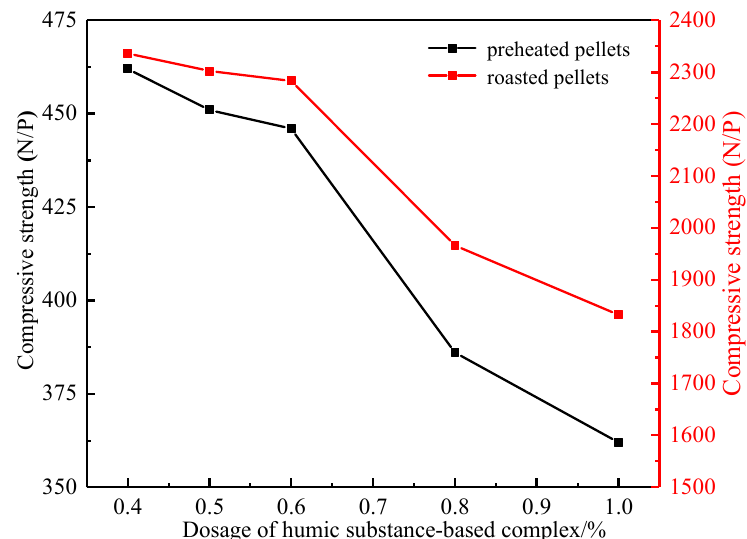
Figure 9. Effects of dosages on the compressive strengths of fired pellets.